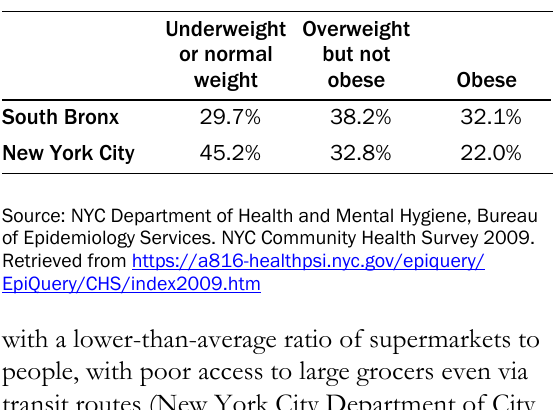
Table 2. Body Weight (Age Adjusted), 2009, South Bronx and New York City (in percentage normal or underweight, overweight, and